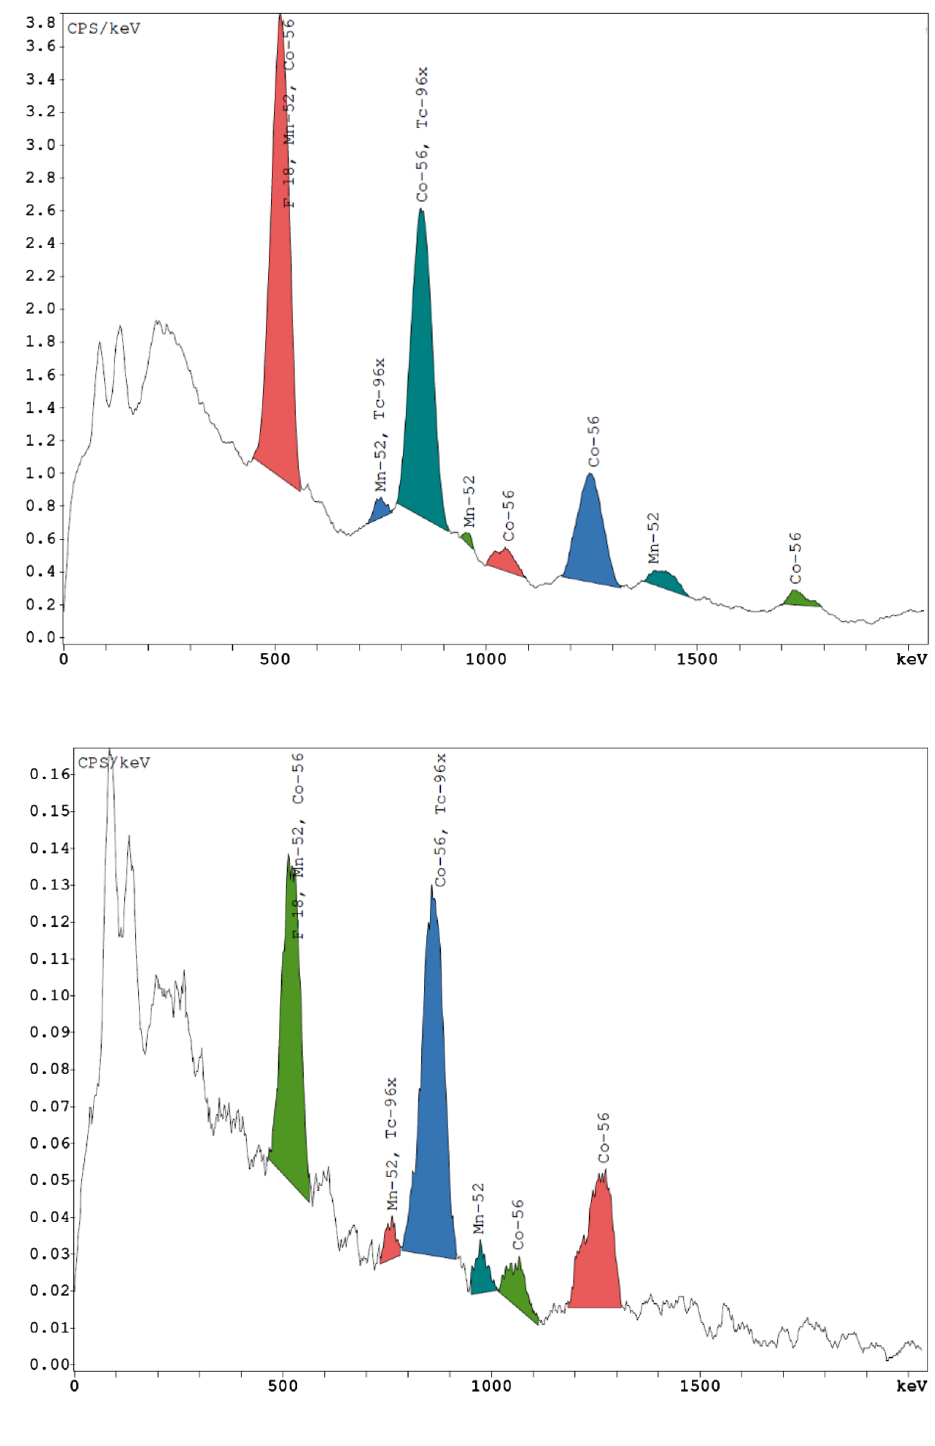
Fig. 1 Gamma spectroscopy data of the bombarded [O-18] water of all productions carried out using Neptis Mosaic RS module